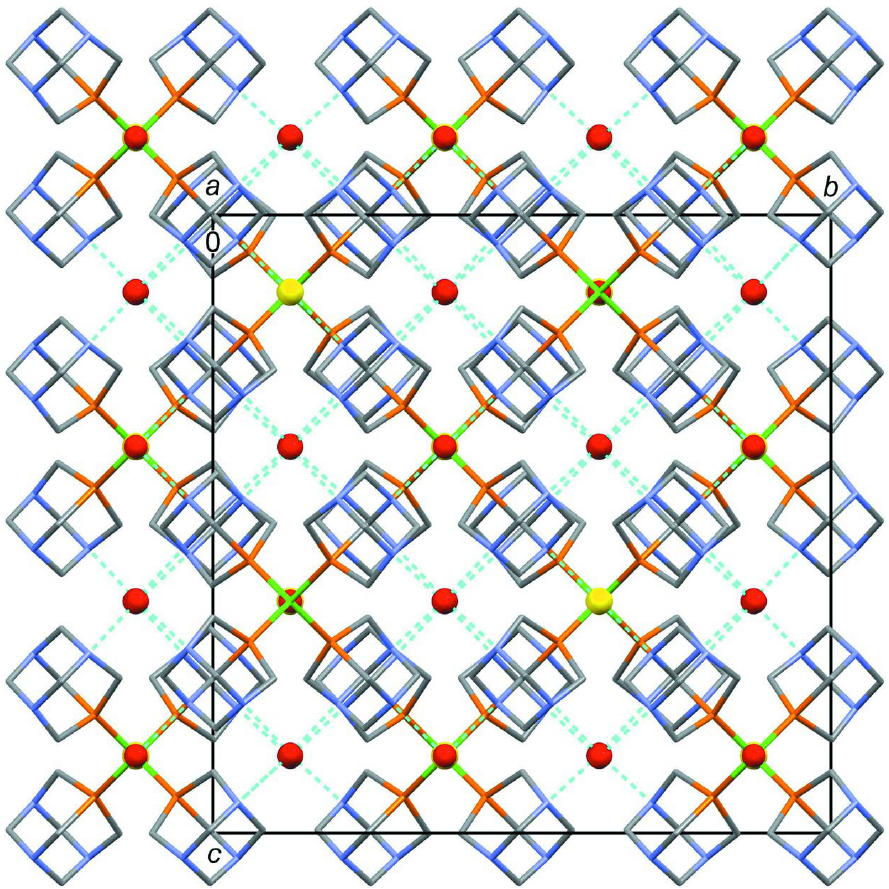
Figure 3 Fragment of the crystal packing diagram of (I) (view along the a axis) showing the extensive hydrogen bonding interactions (pale blue dashed lines) resulting in the formation of a regular three-dimensional H-bonded supramolecular assembly. H atoms are omitted for clarity. Cu, green; P, orange; N, blue; C, grey; O, red (balls); Cl, yellow (balls). tetrakis(1,3,5-triaza-7-phosphaadamantane)copper(I) chloride hexahydrate Crystal